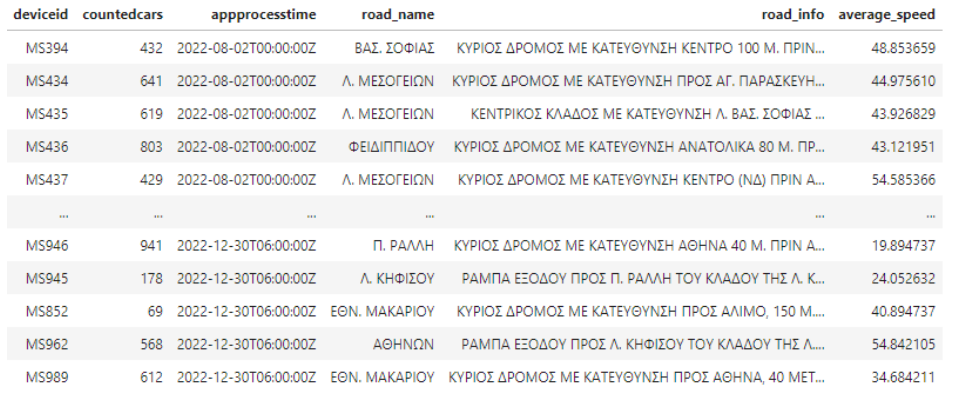
Figure 1. A snapshot of the traffic data from